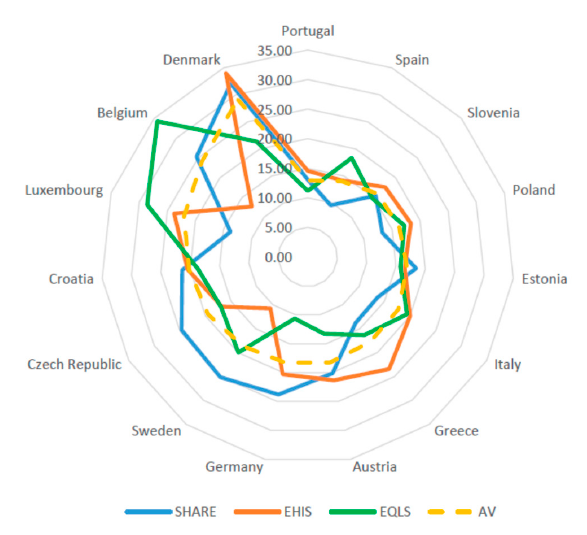
Figure 1. EHIS, SHARE and EQLS: Informal Caregivers over 50 (weighted), (percent). SHARE = Survey of Health, Ageing and Retirement in Europe; EHIS = European Health Interview Survey; EQLS = European Quality of Life Survey. Table 2. Informal Caregivers over 50, by survey (weighted) (percent). SHARE EHIS EQLS